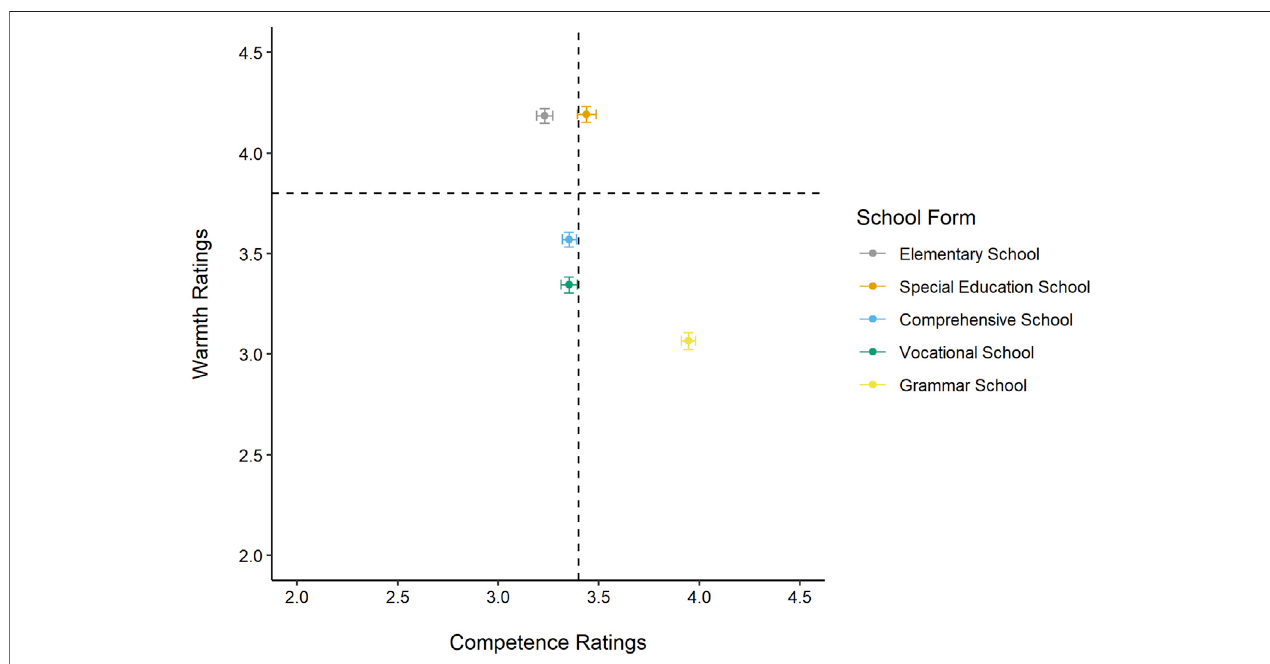
FIGURE 2 | Competence and Warmth Ratings by School Type in Study 2. Note. Mean competence and warmth ratings for different school types on a scale from one to fi ve are shown. Error bars represent standard errors. Dotted lines represent the medians of the competence and warmth